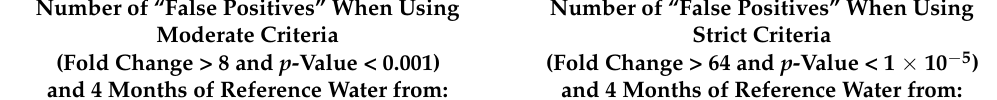
Table 1. The number of “false positives”—defined as compounds exceeding the set criteria of relative concentration and significance—detected in the 30 individual DW samples when using four different sets of reference samples (Jönköping, Karlskrona, Karlstad, or ultrapure water). A total of 120 volcano plots were generated; each evaluated using two different sets of criteria. Cases when it was most beneficial to use reference samples from the same DWTP (although sampled at other months) are labeled green. Other cases are labeled yellow. MQ is ultrapure water (Milli-Q) mimicking an analytical setup without having access to any DW reference sample at